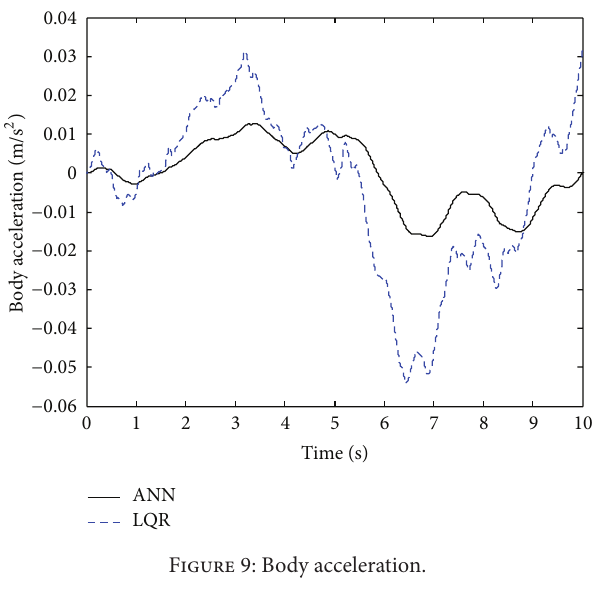
Figure 9: Body acceleration.